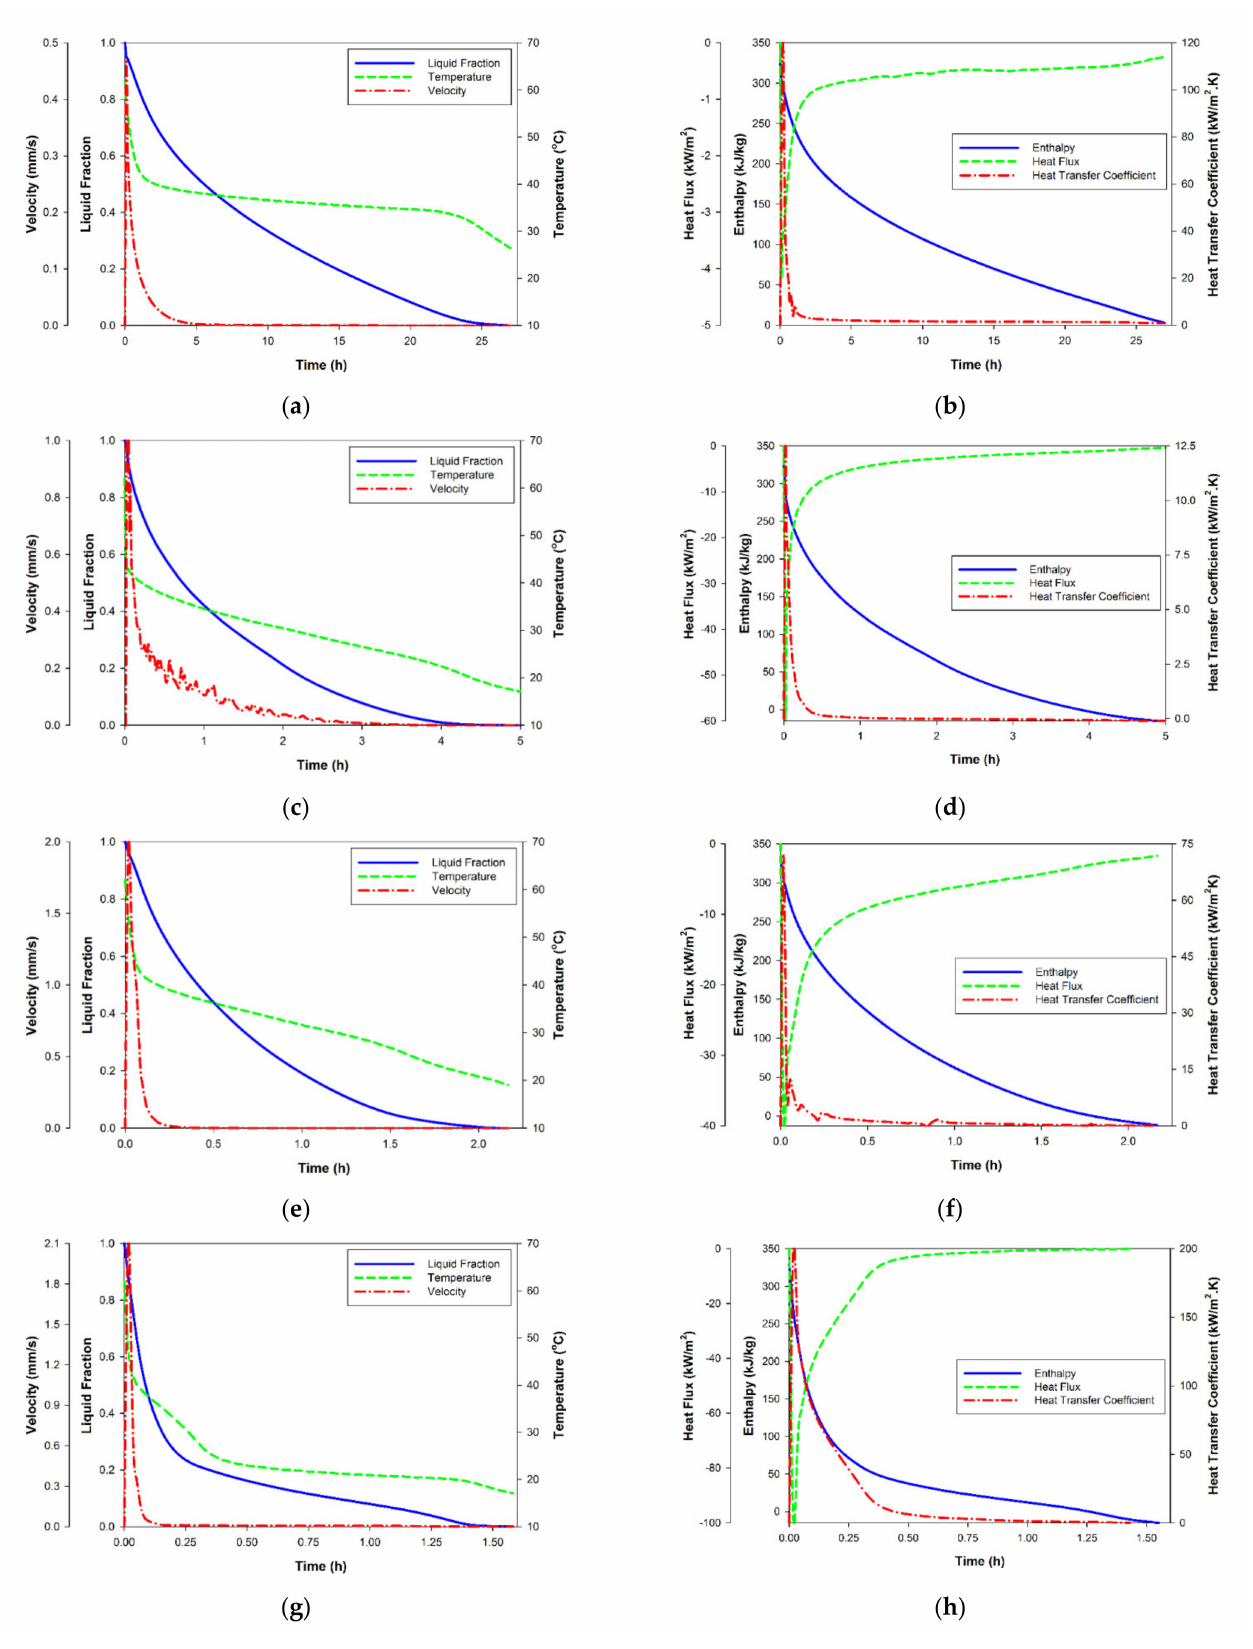
Figure 5. Transient performance of discharging cycles in shell-and-tube with: ( a , b ) 2.5% GNP and no-fins (case 2), ( c , d ) longitudinal fins (case 3), ( e , f ) radial fins (case 4) and ( g , h ) wire-wound fins (case